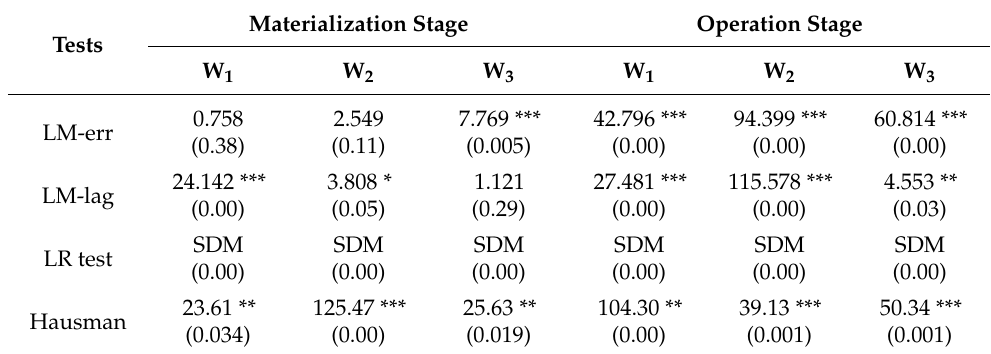
Table 3. The results of tests.